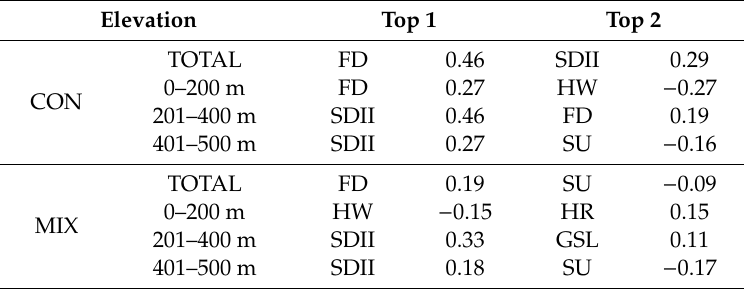
Table 4. Top 1 and Top 2 influential climate extremes for total area and classes on elevation. The table shows major influential climate factors on changes in EVIavg. The results of eight Bayesian networks are indicated for coniferous and mixed forests 1 .